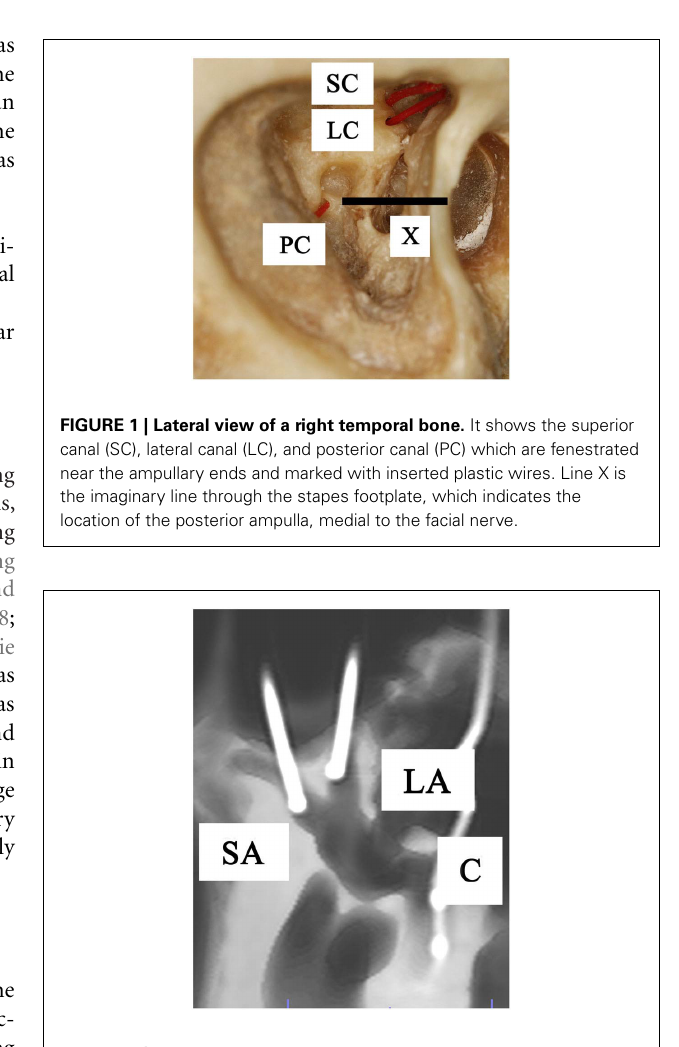
FIGURE 2 |Anterolateral view of a right temporal bone using cone beam CT-scan. It shows the fenestration and insertion of the cochleovestibular electrodes in the superior ampulla (SA), lateral ampulla (LA), and cochlea